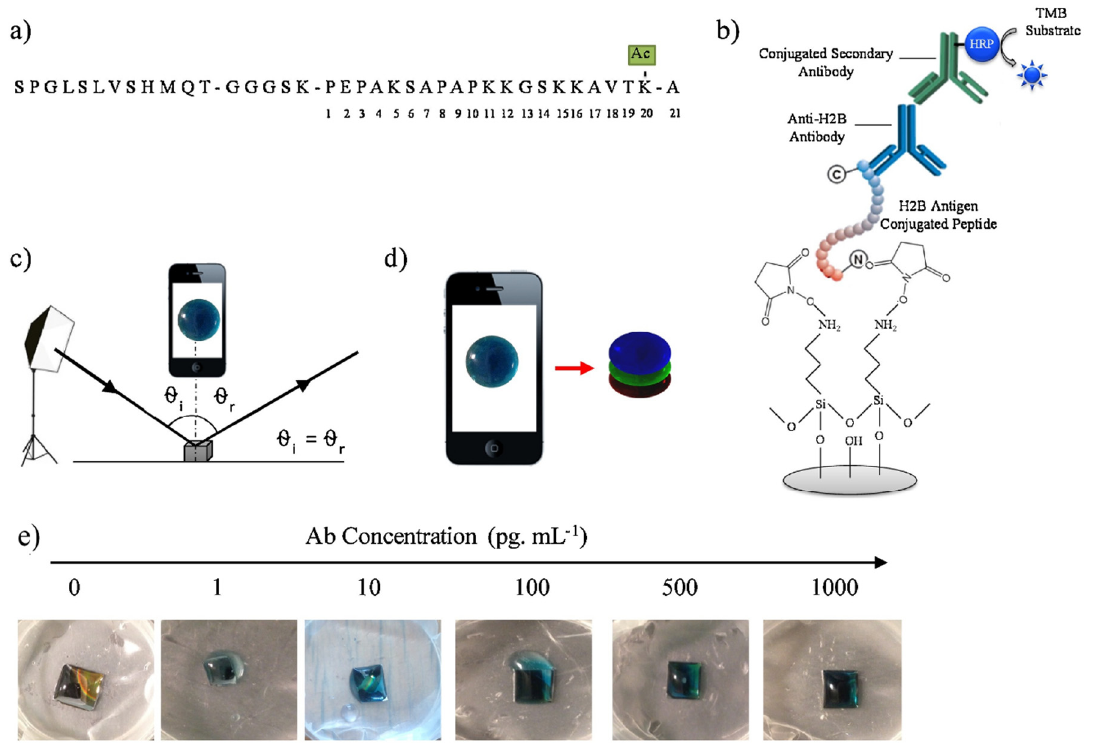
Figure 4. ( a ) The sequence of the 21-mer Si-specific peptide conjugated with the H2 B antigen (the site of acetylation is annotated); ( b ) Schematic representation of the H2 B glass sensor; ( c ) The measuring scheme, ( d ) the red-green-blue (RGB) layers of the obtained colored product; ( e ) Generation of colored solution by TMB-HRP reaction after capture of H2 B antibody on PSi. Color intensity depends on the concentration of the captured Anti-H 2 B antibody [73].